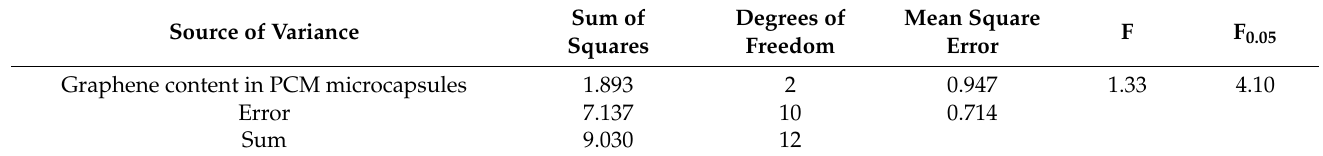
Table 8. Variance analysis of the bending strength results in the performed beam bending tests.